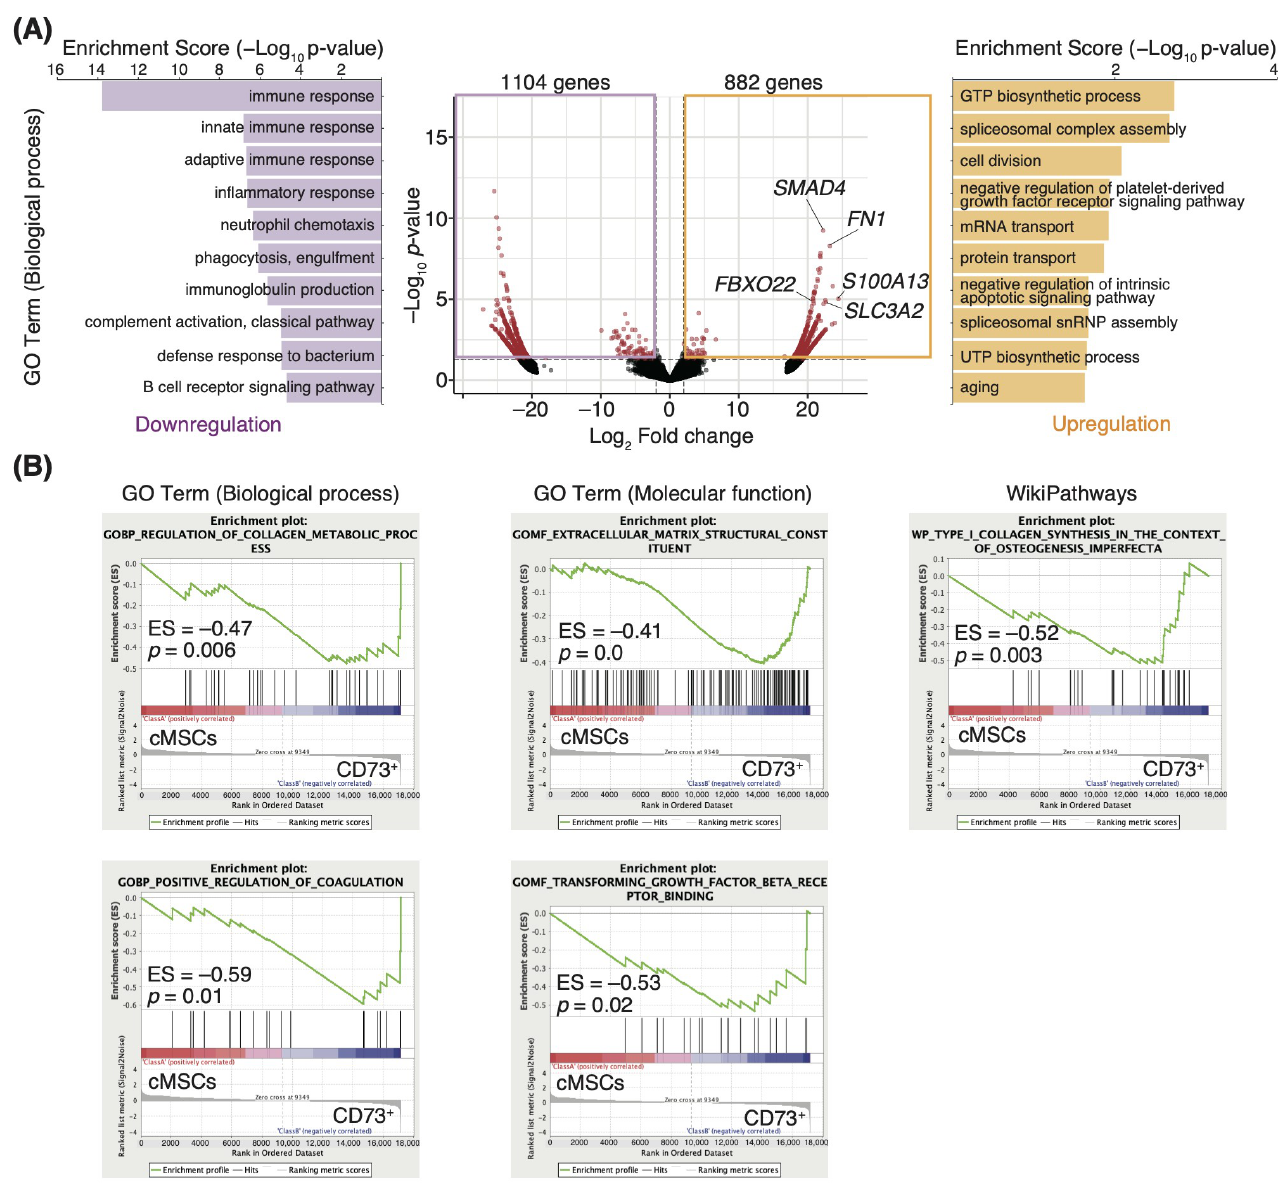
Figure 2. CD73 + cells exhibit upregulated expression of genes, related to extracellular matrix (ECM) remodeling and the downregulated expression of genes related to the immune response compared with cMSCs. ( A ) mRNA-seq-based measurements of gene expression changes in CD73 + cells com- pared with cMSCs, isolated from human adipose tissues. n = 3 specimens. Volcano plots showing differentially expressed genes (log2 fold-change >1 or < – 1 (vertical dashed lines), and p < 0.05 (hor- izontal dashed line)). Graphs showing the top 10 enriched gene ontology (GO) biological process terms. The left panel shows the downregulated genes, and the right panel shows the upregulated genes in CD73 + cells. ( B ) Gene set enrichment analysis of CD73 + cells and cMSCs. ES, enrichment score.